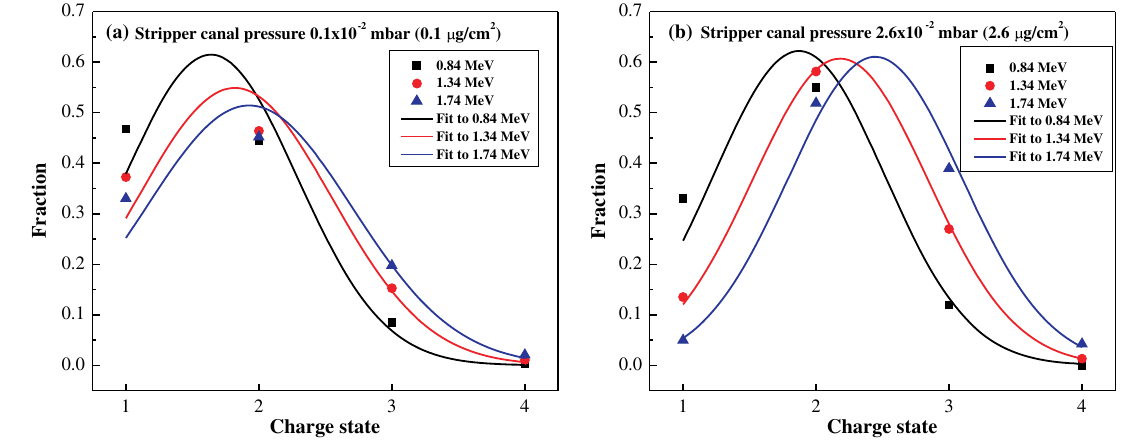
FIG. 6. Fractional distribution of charge states at different incident ion energies measured at stripper gas pressure (a) 0 : 1 (cid:3) 10 (cid:1) 2 mbar and (b) 2 : 6 (cid:3) 10 (cid:1) 2 mbar .